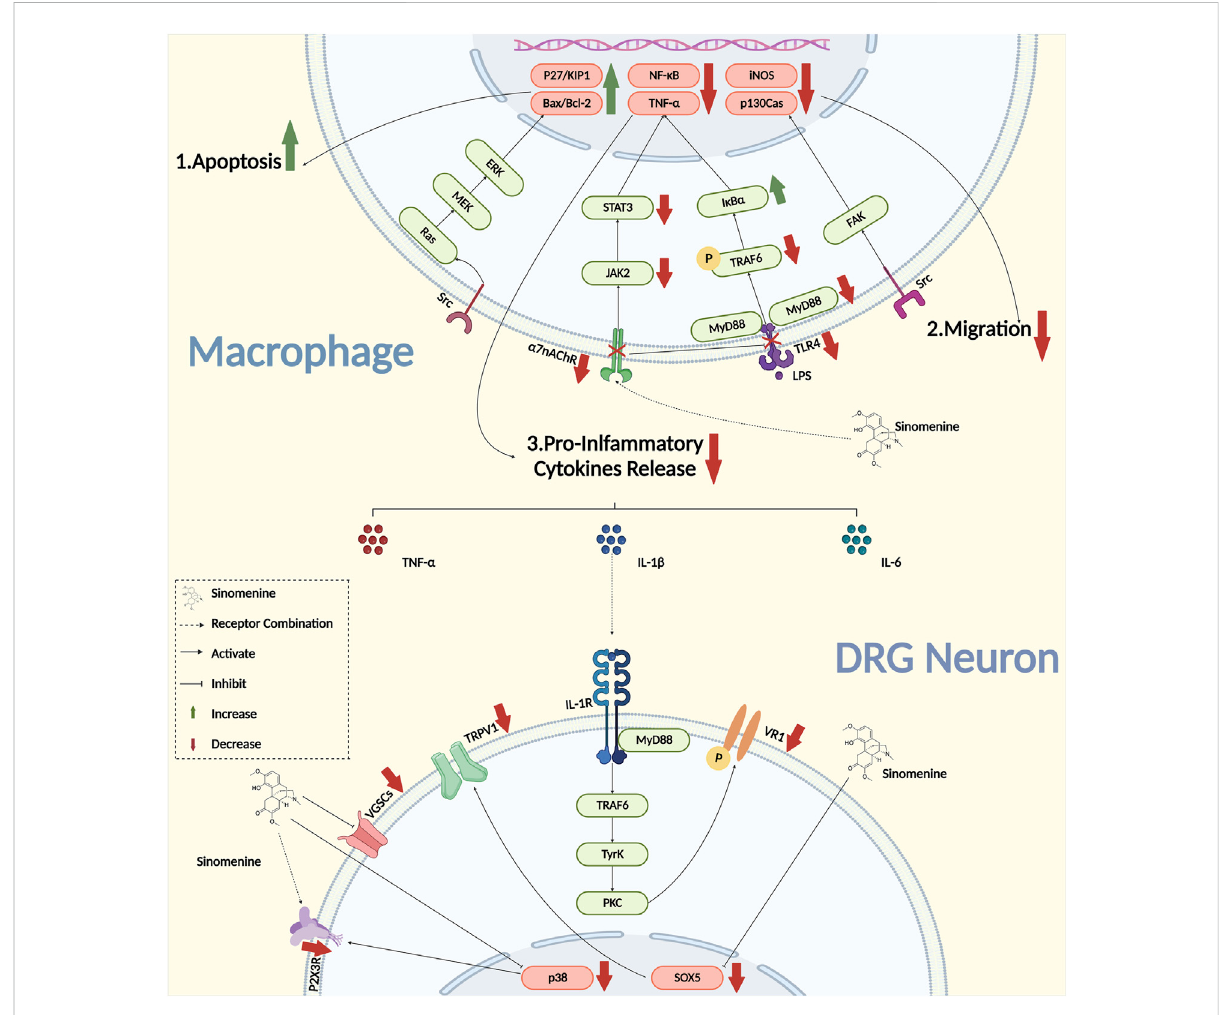
FIGURE 2 The interaction between macrophages and neurons under the intervention of